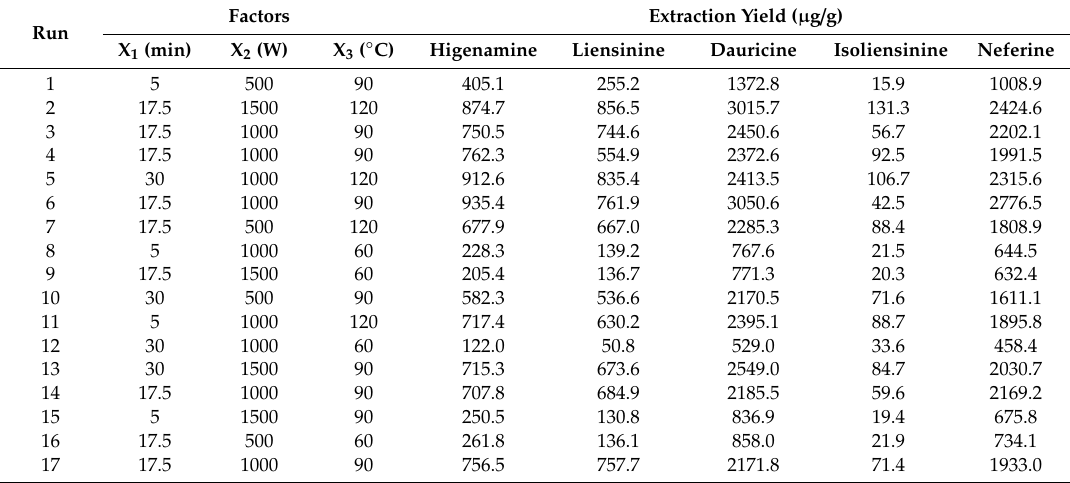
Table 2. Experiment conditions and the extraction yields of the alkaloids for the Box–Behnken design. Factors Extraction Yield ( µ g / g) Run X 1 (min) X 2 (W) X 3 ( ◦ C) Higenamine Liensinine